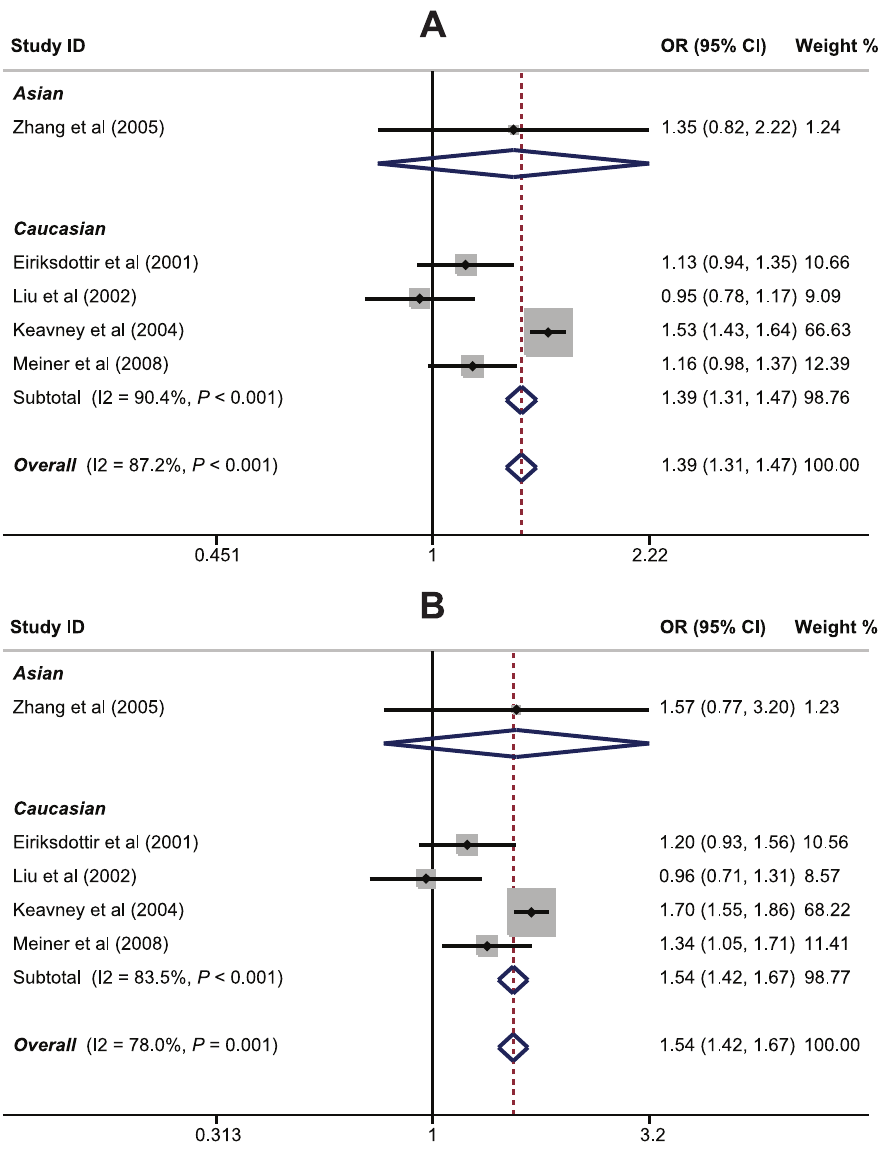
Figure 3. Subgroup analysis by ethnicity for the relationships between CETP rs708272 (C . T) polymorphism and myocardial infarction risk under the allele and dominant